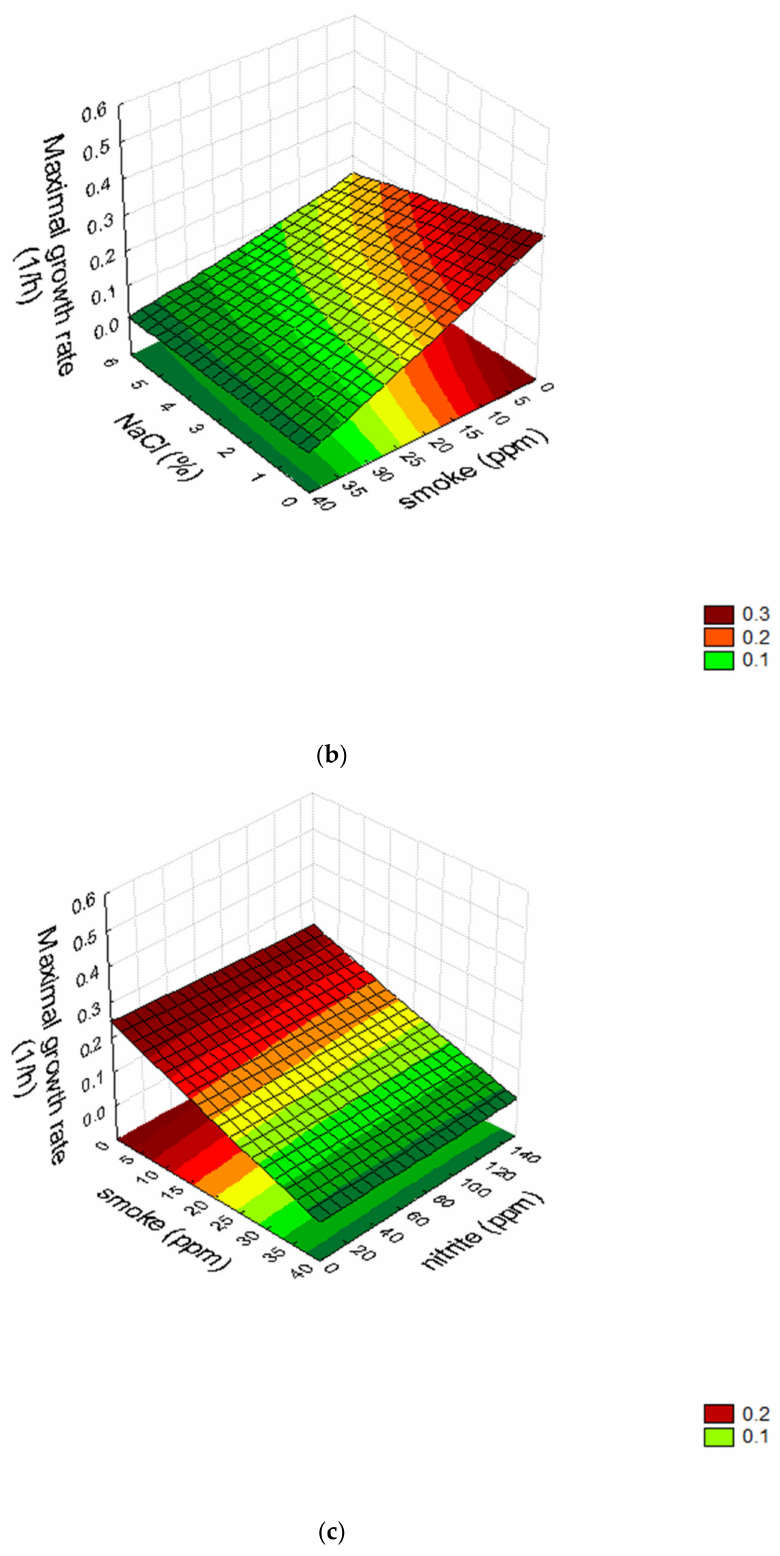
Figure 2. Surface response plots for the interactions liquid smoke × temperature ( a ), liquid smoke × salt ( b ), and nitrite × liquid smoke ( c